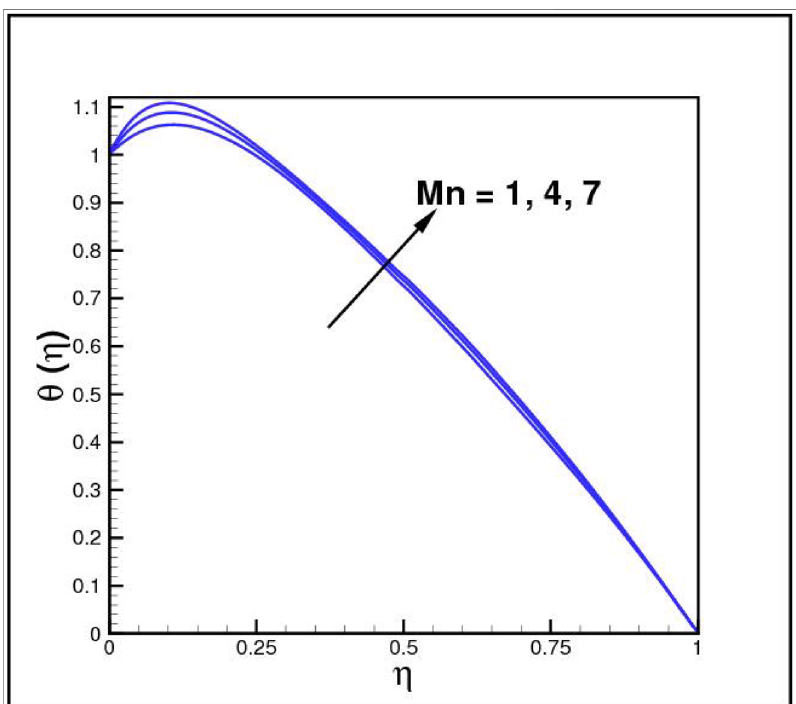
Figure 12. Impact of Mn on θ ( η